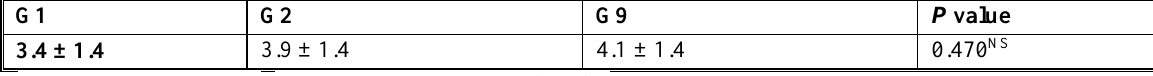
Table 8b. Association between duration of diarrhea and rotavirus genotype